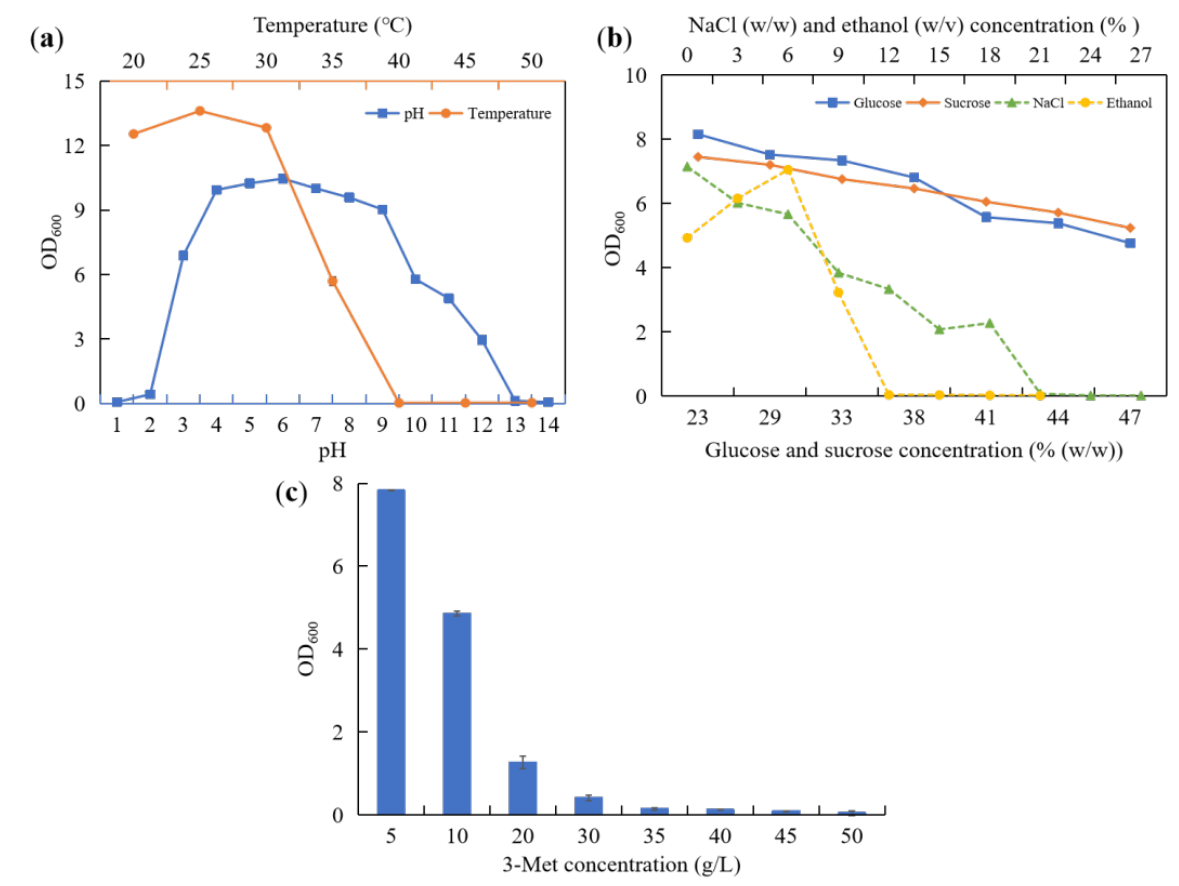
Figure 1. The range of growth temperature and pH ( a ) and the tolerance of glucose, sucrose, NaCl and ethanol ( b ) and 3-Met ( c ) of strain YHM-G.